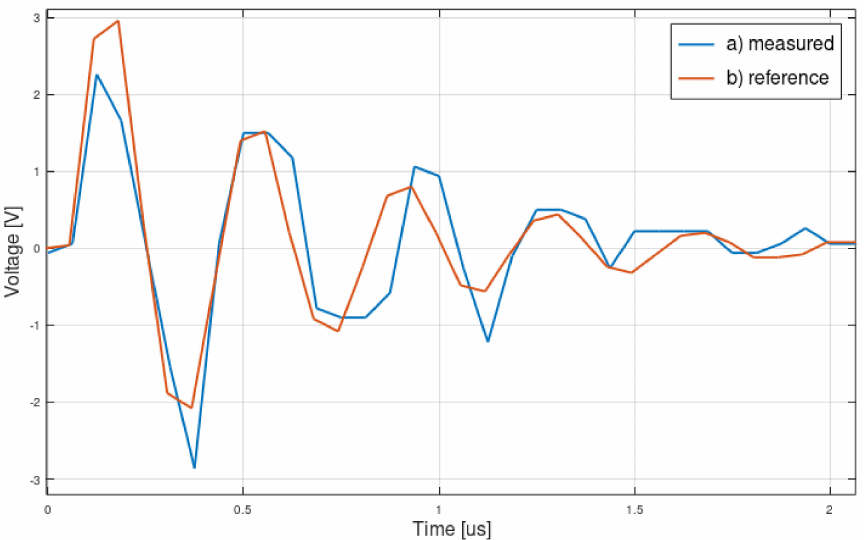
Figure 11. Fading sine wave measured by prototype and reference oscilloscope (2.5 MHz) to show system